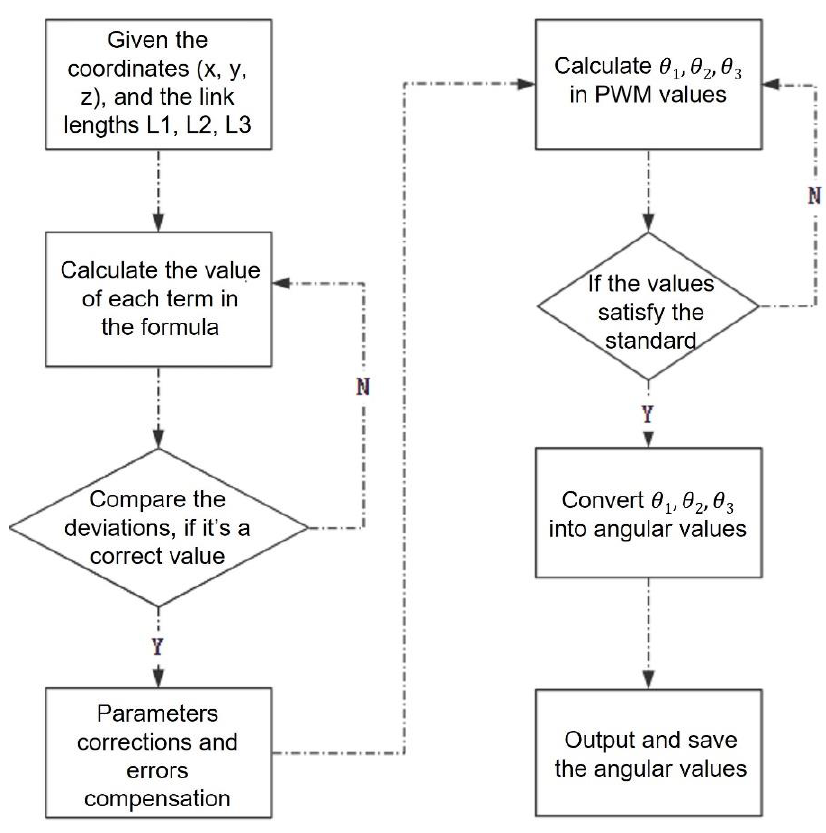
Figure 14. Inverse kinematics solution flow of mechanical arm geometry method.